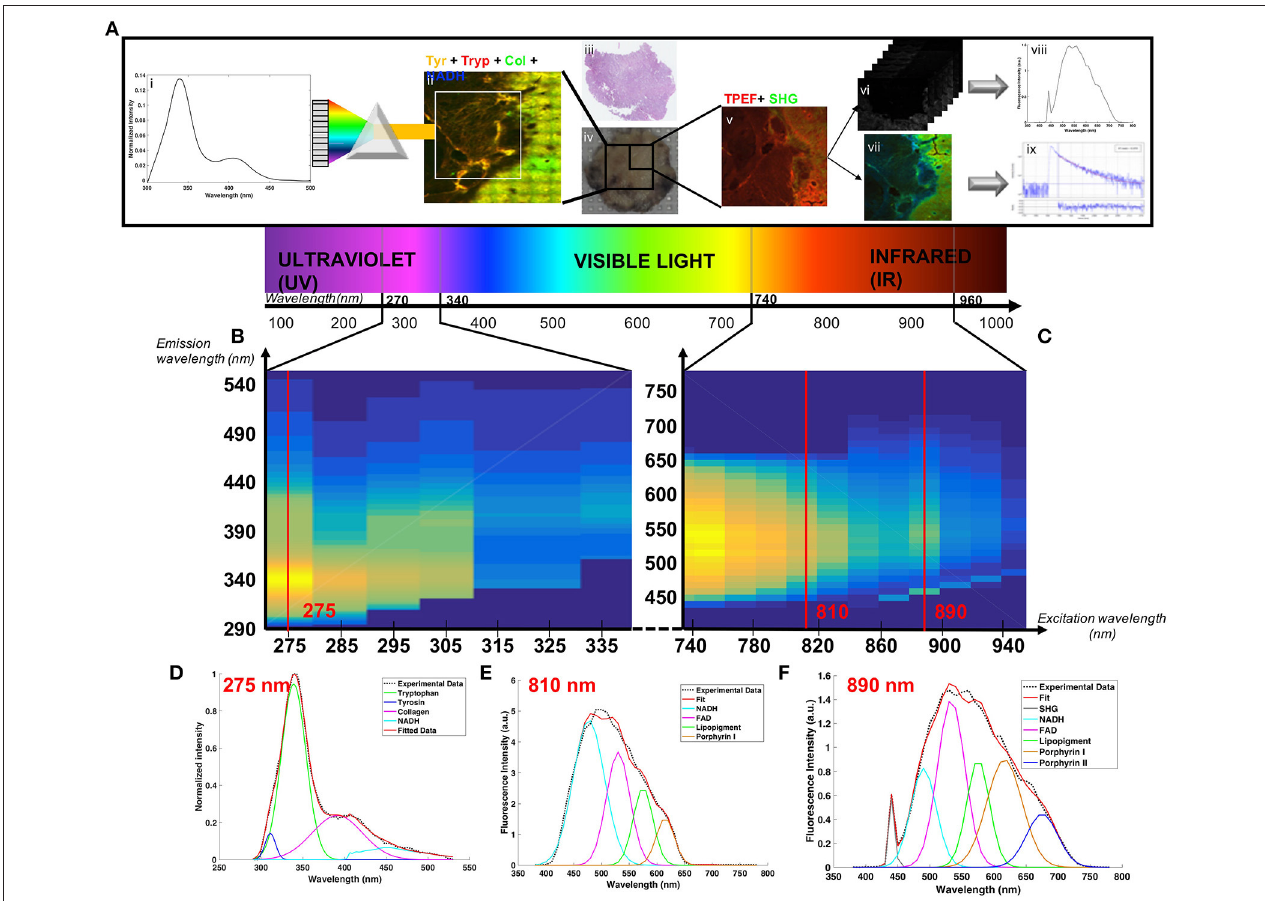
FIGURE 1 | (A) Schematic of the acquisition-analysis protocol from deep-UV to infrared excitation (B) Deep-UV excitation-emission matrix. (C) Two-photon (NIR excitation) excitation-emission matrix. The bottom line present how were fitted tyrosin, tryptophan, collagen crosslinks and NADH at 275nm (D) , NADH, FAD, lipopigments, porphyrin I and porphyrin II at 810nm (E) and SHG, NADH, FAD, lipopigments, porphyrin I and porphyrin II at 890nm (F) .